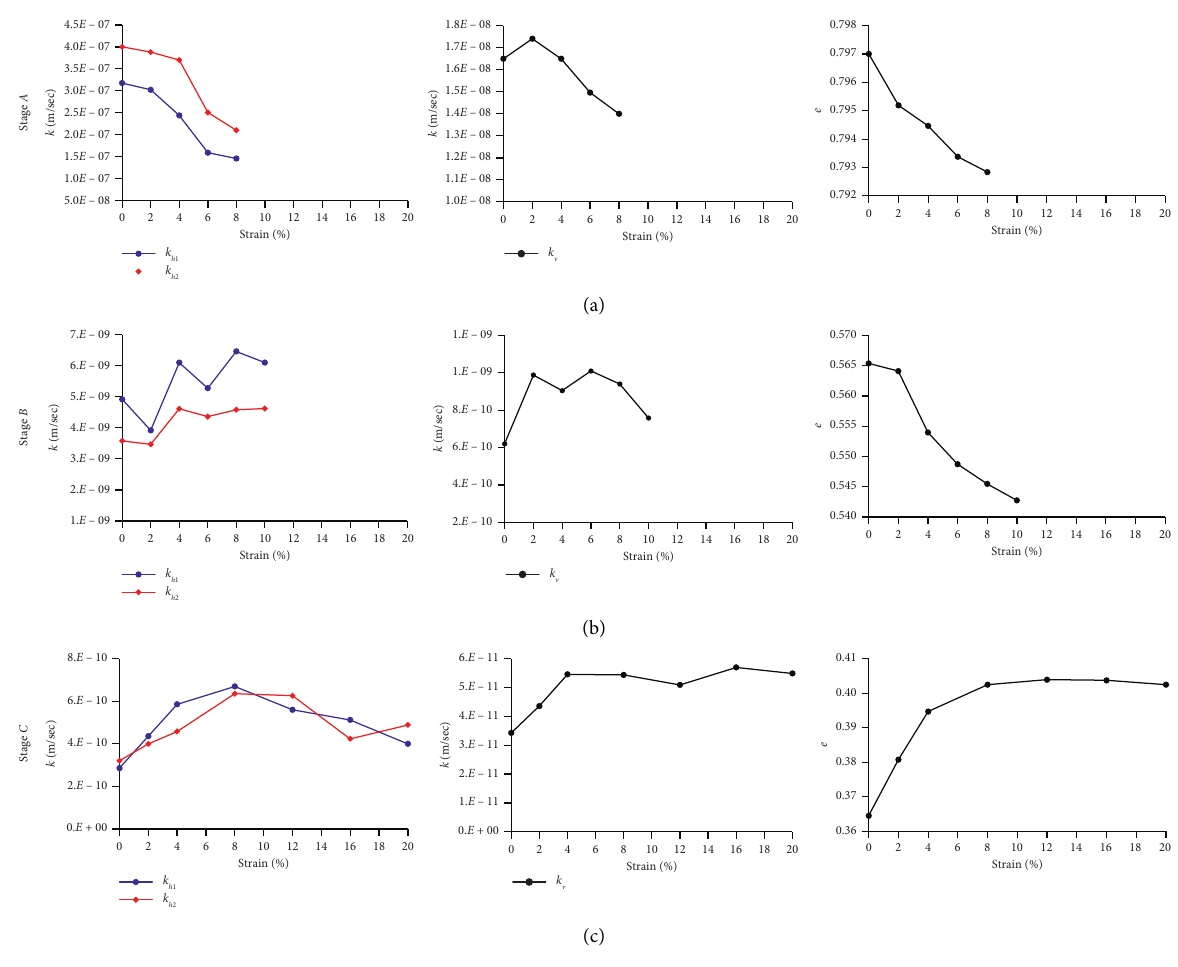
Figure 8: Variation graphs of k